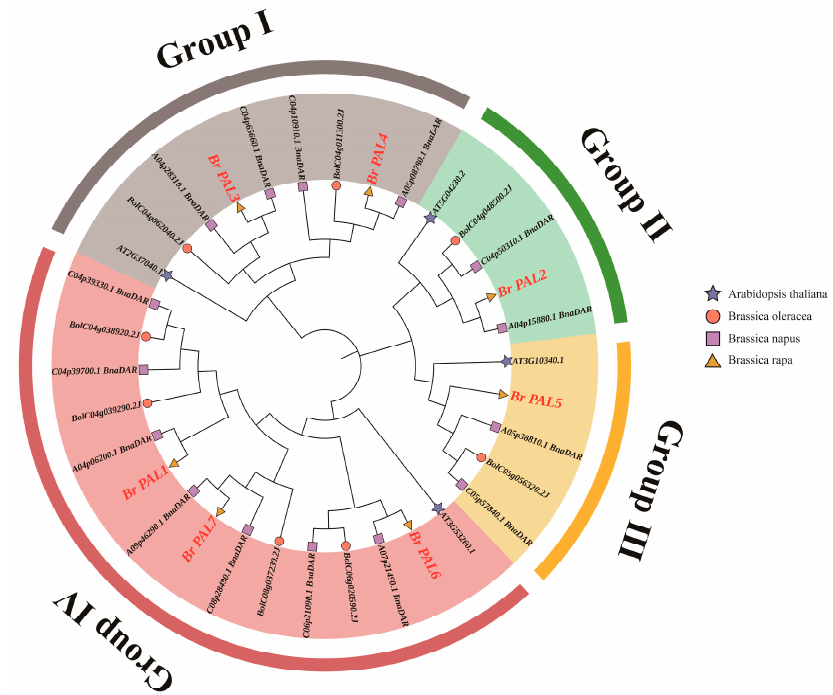
Figure 2. Phylogenetic tree of PAL from Brassica rapa (triangle), Arabidopsis (pentagram), Brassica oleracea (circle), and Brassica napus (square).